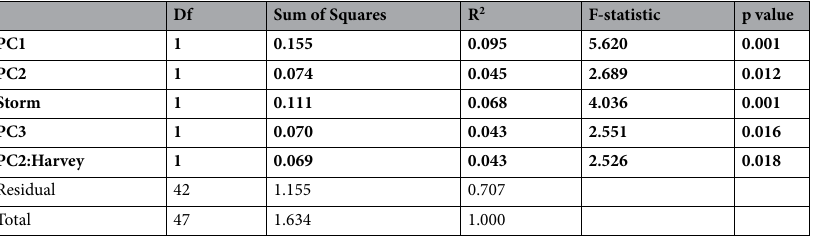
Table 3. Results of the top PERMANOVA (n = 48) chosen by AICc. PC1, PC2, and PC3 are coefficients from principal coordinates analysis and are described in Table 2. ‘Harvey’ represents a binary contrast of Harvey v non-storm years. Significant predictors of zooplankton community structure are bolded (α ≤ 0.05).